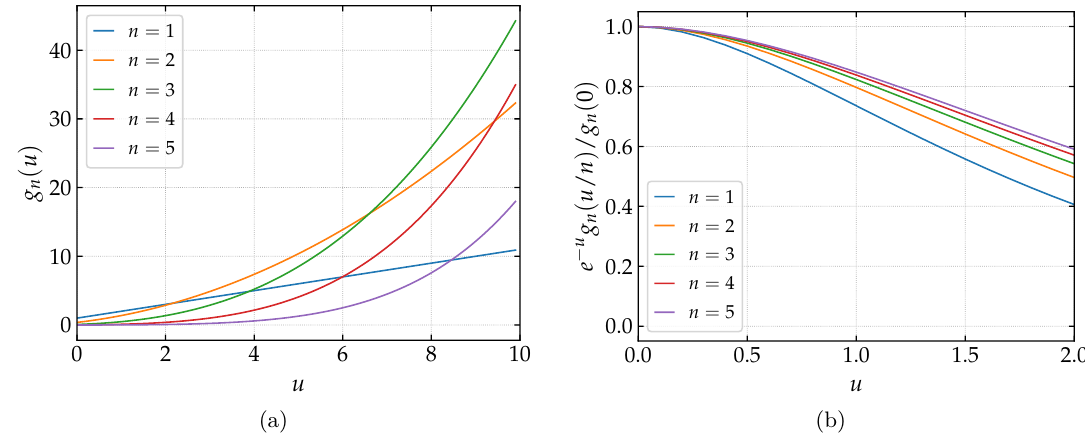
Figure 7. (Left) The first five polynomial functions g n ( u ) . (Right) Scaling behavior of the poly- nomial functions g n ( u ) for large n (see text for